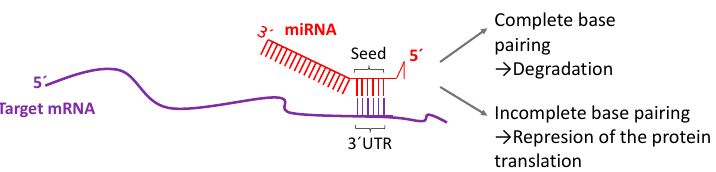
Figure 2. Complementary binding between mRNA and miRNA at the seed region located on the bases 2–8 on the 5´ end of mature miRNA and the 3´UTR of the target